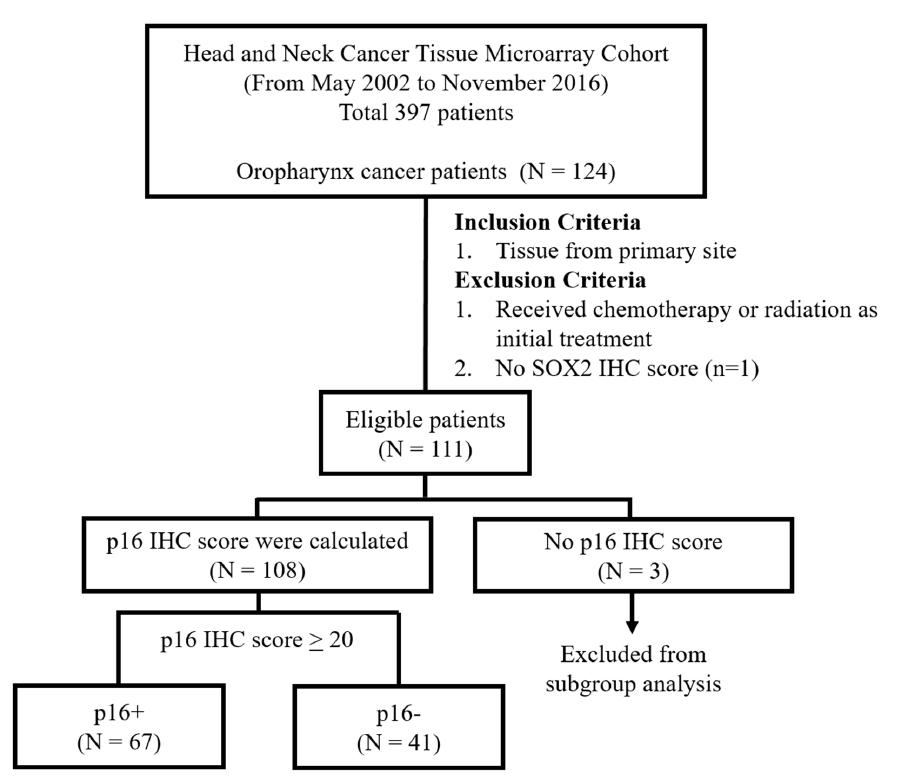
Figure 1. Schematic diagram of the study design.